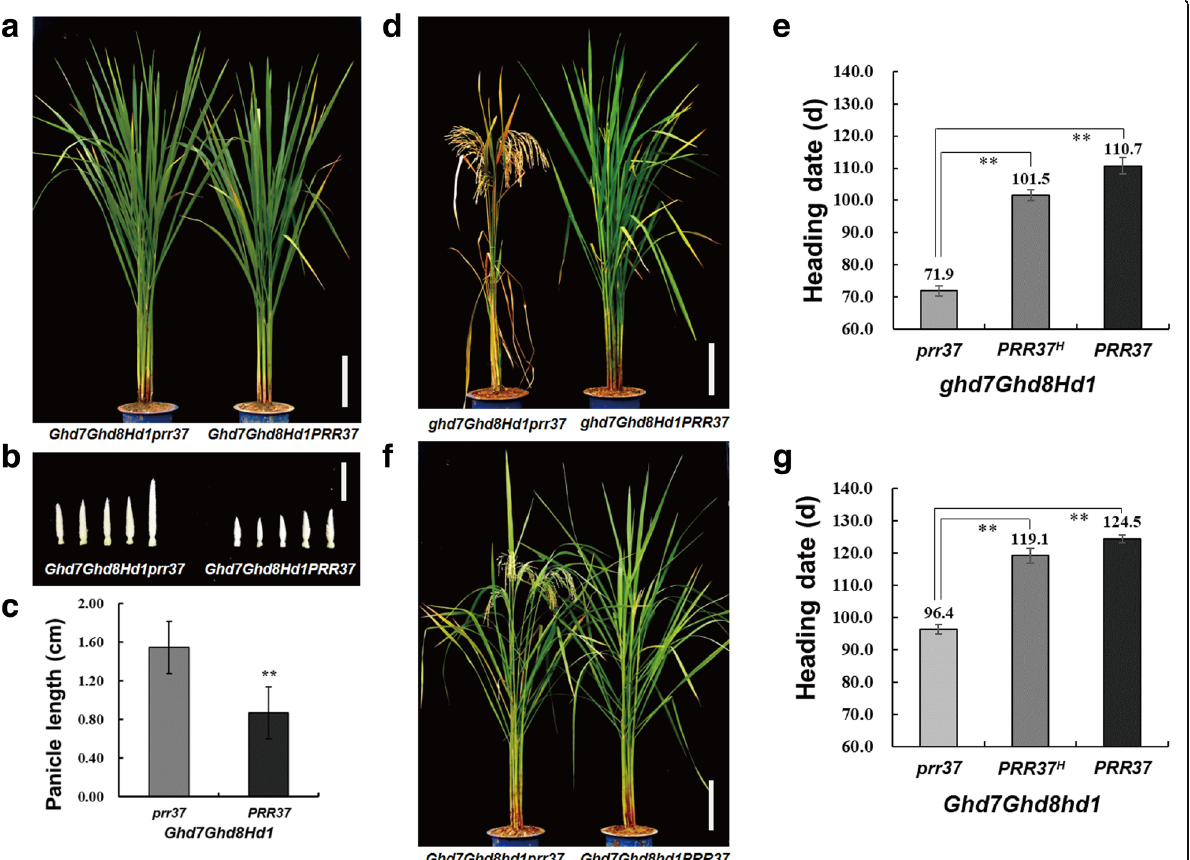
Fig. 2 PRR37 delays heading date under NLD conditions. Non-heading plants of prr37 and PRR37 a in the Ghd7Ghd8Hd1 background, b their young panicles of main stems and c the comparison of panicle length. d The plants of ghd7Ghd8Hd1PRR37 and ghd7Ghd8Hd1prr37 . e The large effect of PRR37 on heading date in the ghd7Ghd8Hd1 background. f The plants of Ghd7Ghd8hd1PRR37 and Ghd7Ghd8hd1prr37 . g The strong effect of PRR37 on heading date in the ghd7Ghd8Hd1 background. **, P < 0.01 based on Student ’ s t -test; n = 15 for each combination in c , and n ≥ 10 for each genotype in e and g . PRR37 H , the heterozygous allele of PRR37 . Scale bars: 20 cm for a , d and f , and 1 cm for b